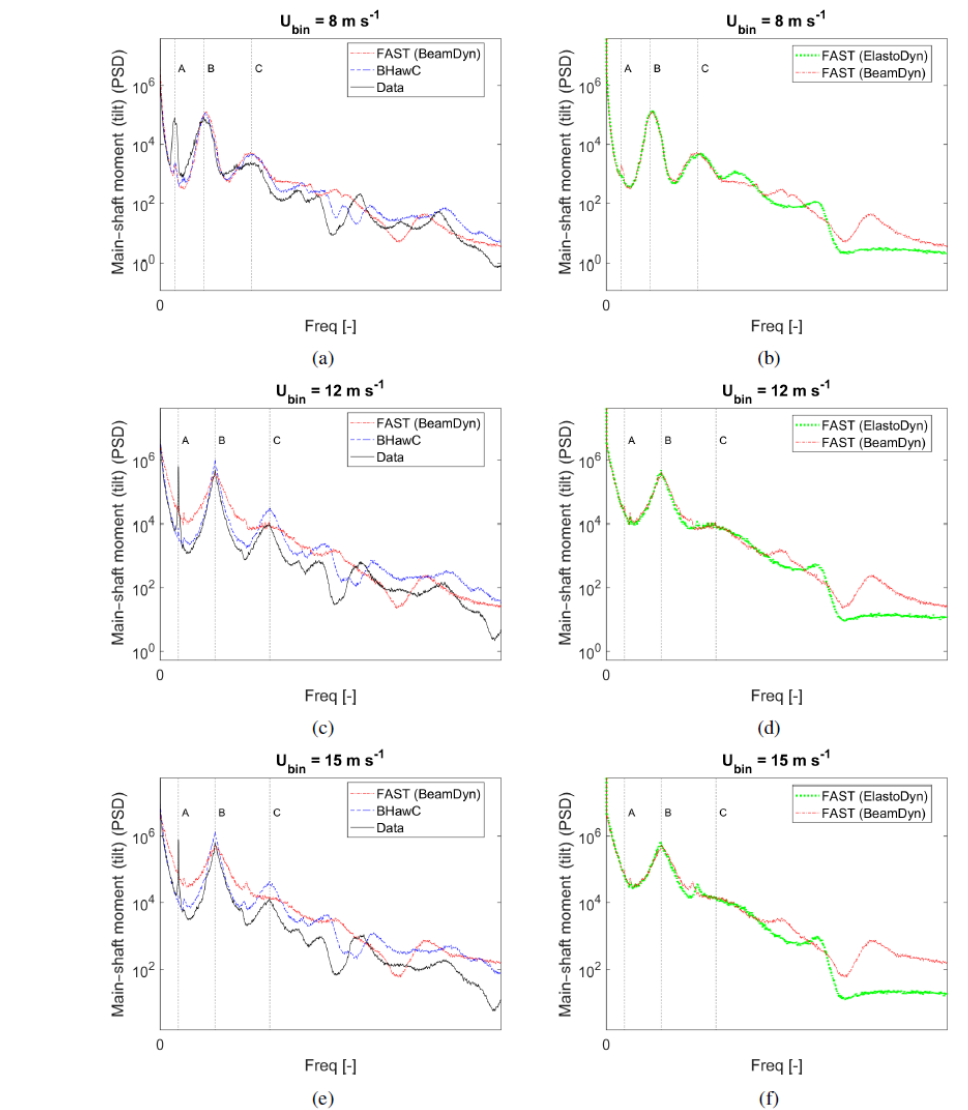
Figure 20. PSDs of the main-shaft bending moment – tilt (nonrotating coordinate system). The three sets of graphs represent the ensemble- averaged PSDs from the inflow velocity bins at 8ms − 1 (top), 12ms − 1 (center), and 15ms − 1